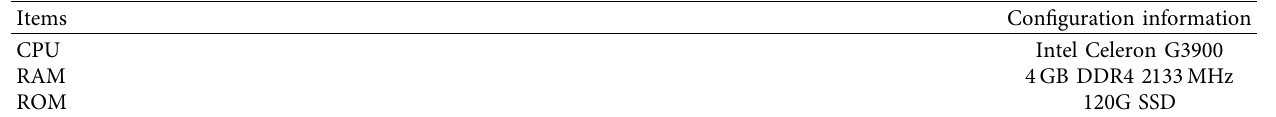
Table 10: Configuration of the train’s onboard